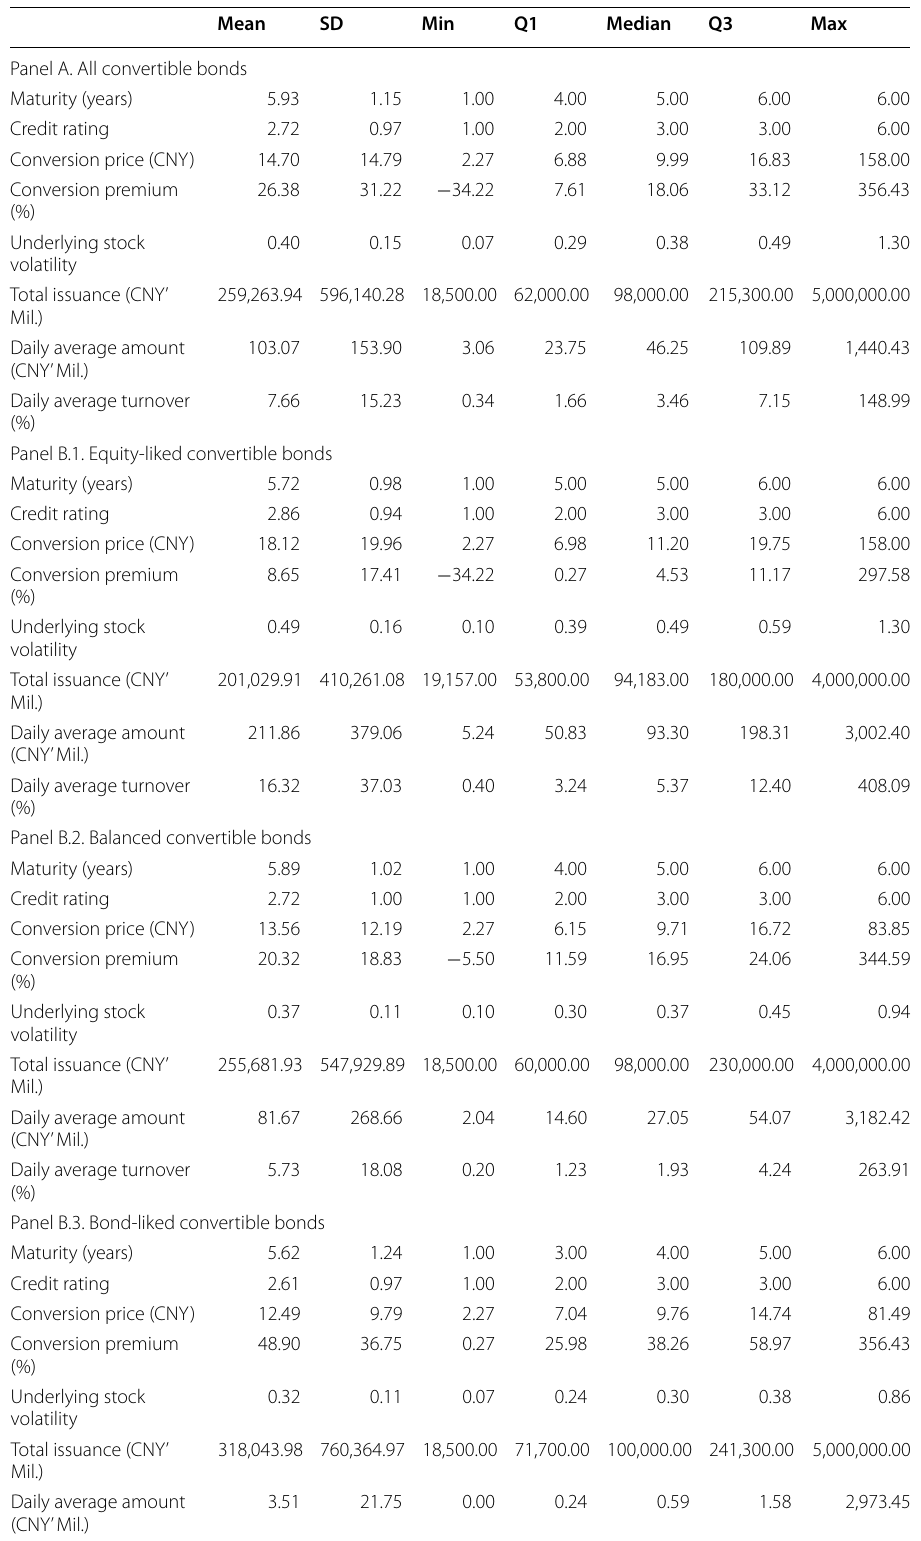
Table 2 Summary statistics of the